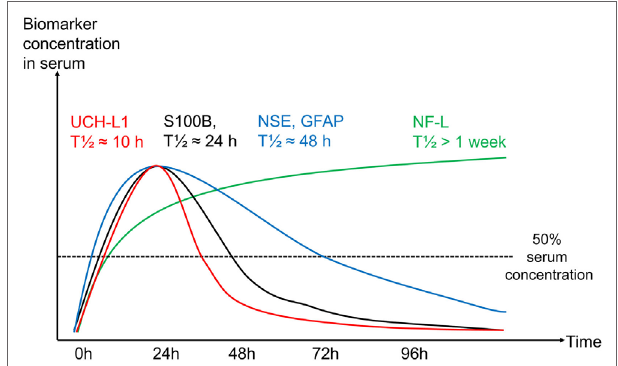
FigURe 4 | Protein kinetics for each protein in serum over time. Graph illustrating how the influence of an increasing effective half-life results in a serum sample in an uneventful traumatic brain injury (TBI) (without secondary deterioration) for ubiquitin carboxy-terminal hydrolase L1 (UCH-L1) (red), S100B (black), neuron-specific enolase (NSE)/glial fibrillary acidic protein (GFAP) (blue), and neurofilament light (NF-L) (green). Biomarker concentration in serum on y -axis and time in hours on x -axis. Note that these are estimates based on the knowledge of S100B kinetics in serum, current literature makes it difficult to illustrate more accurate trajectories over time for the other